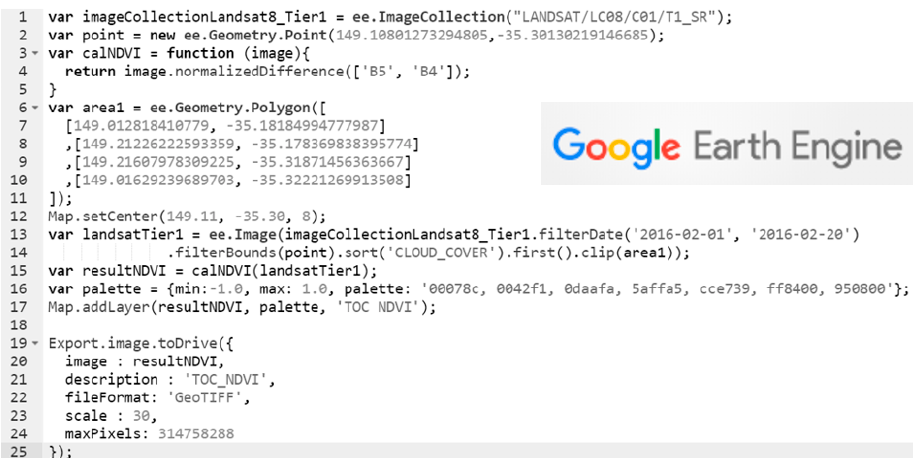
Figure 6. Script for NDVI processing in the Canberra region, Australia, covered by Landsat-8 OLI (6 February 2016) in the Google Earth Engine code editor.